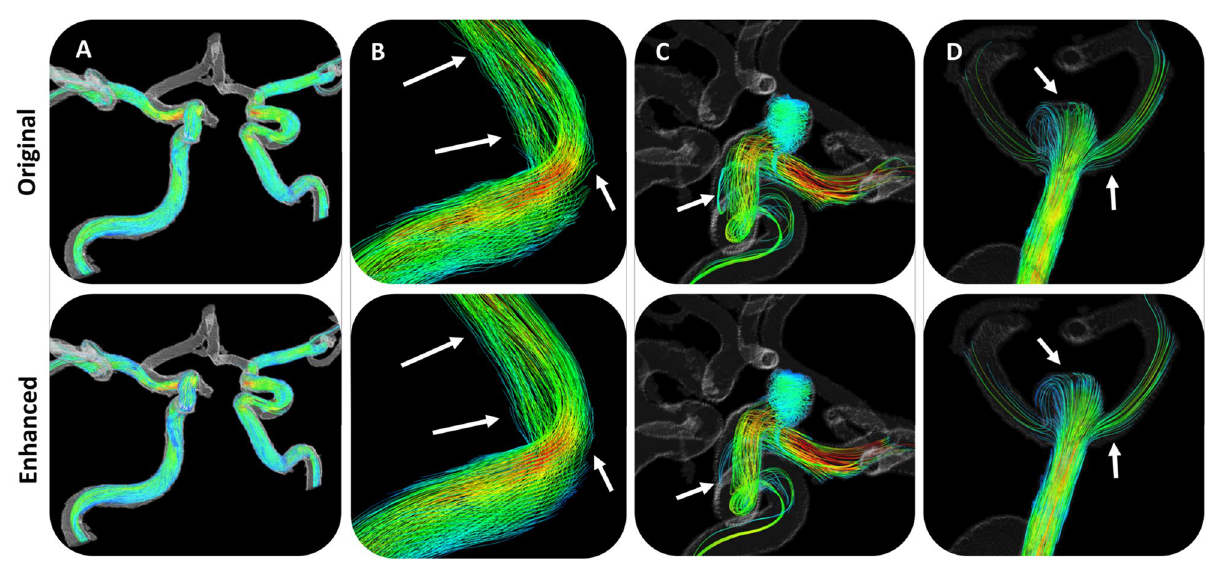
Figure 7. Velocity streamlines throughout select patient cerebrovascular anatomy. ( A ) A broad view of streamlines through the right and left ICA and MCA reveals no major difference in streamlines length or quality between original and enhanced flow fields, however a zoomed in view of an ICA vessel bend in ( B ) shows that streamlines from the original flow field tend to point and terminate outside of the vessel wall, while streamlines in the enhanced flow field tend to stay normal to the path of flow. ( C ) Streamlines in an ICA aneurysm ( D ) Streamlines in an MCA